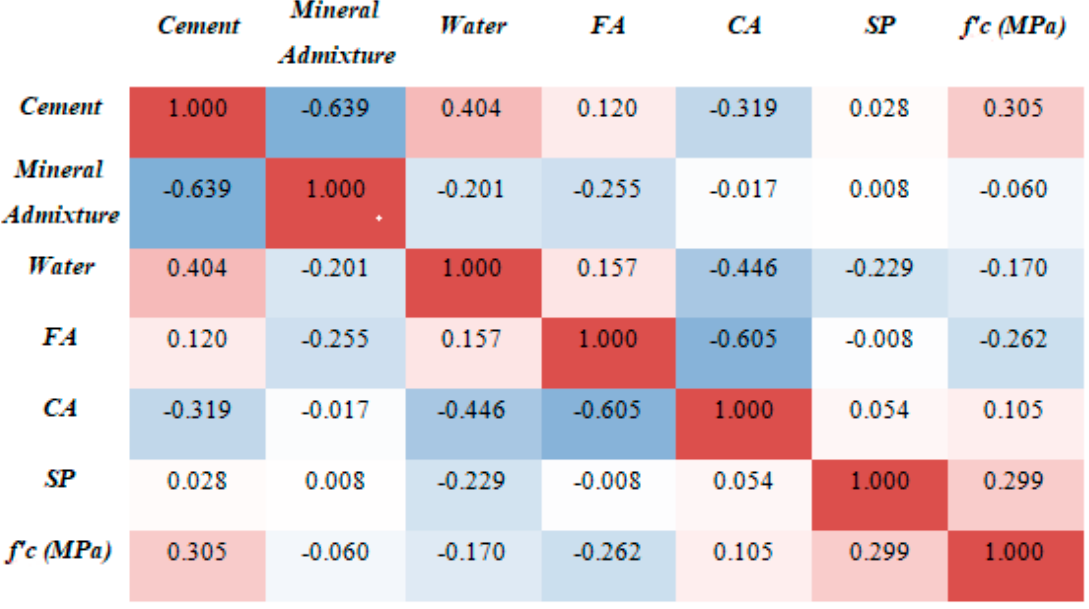
Figure 4. Multi-correlation graph between input and output variables.